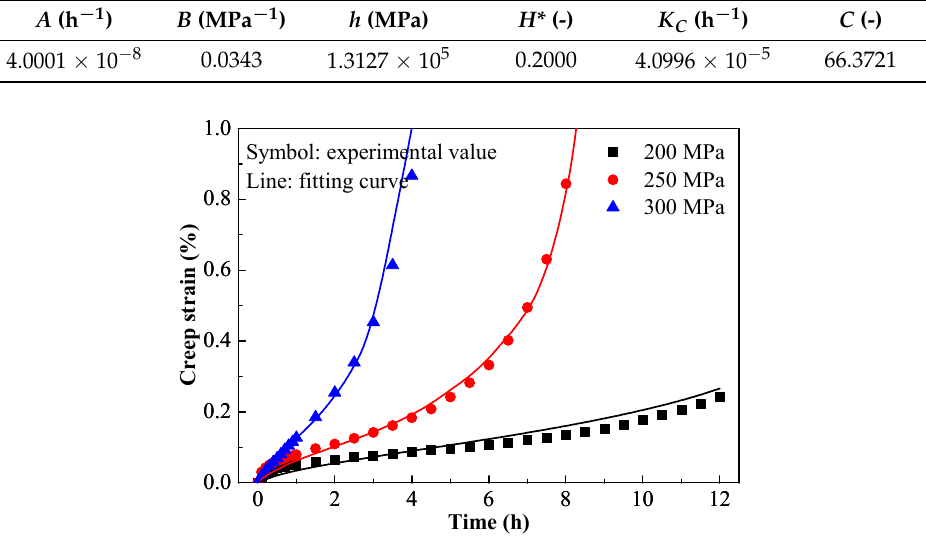
Figure 10. Comparison between experimental and calculated creep strains of AA7050.